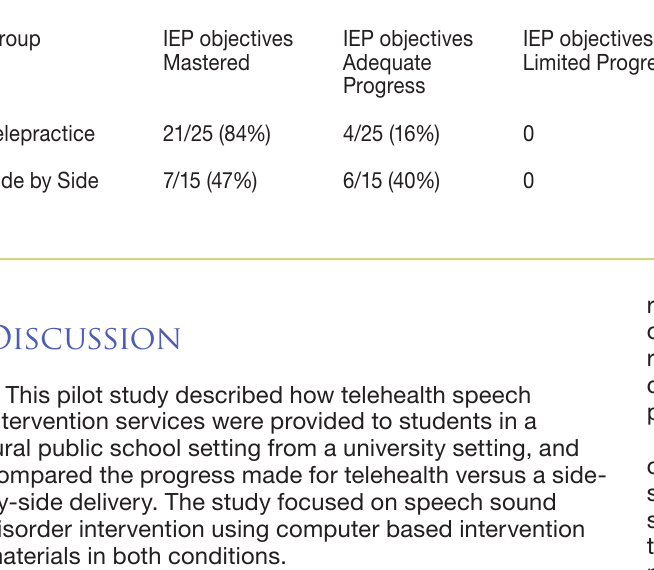
Table 8. Comparison of fourth quarter progress report results by intervention